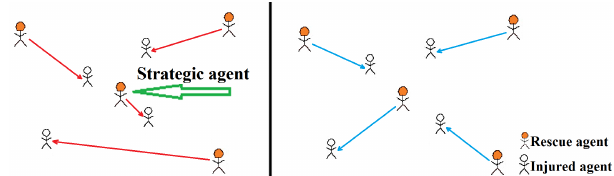
Figure 3. Strategic agent illustration. Blue arrows show the final results for strategy 2, and red arrows show the successful rescuers in strategy 3.